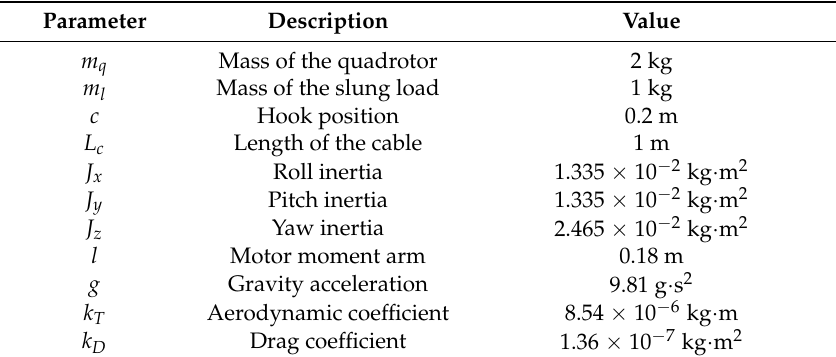
Table 1. Quadrotor parameters used in